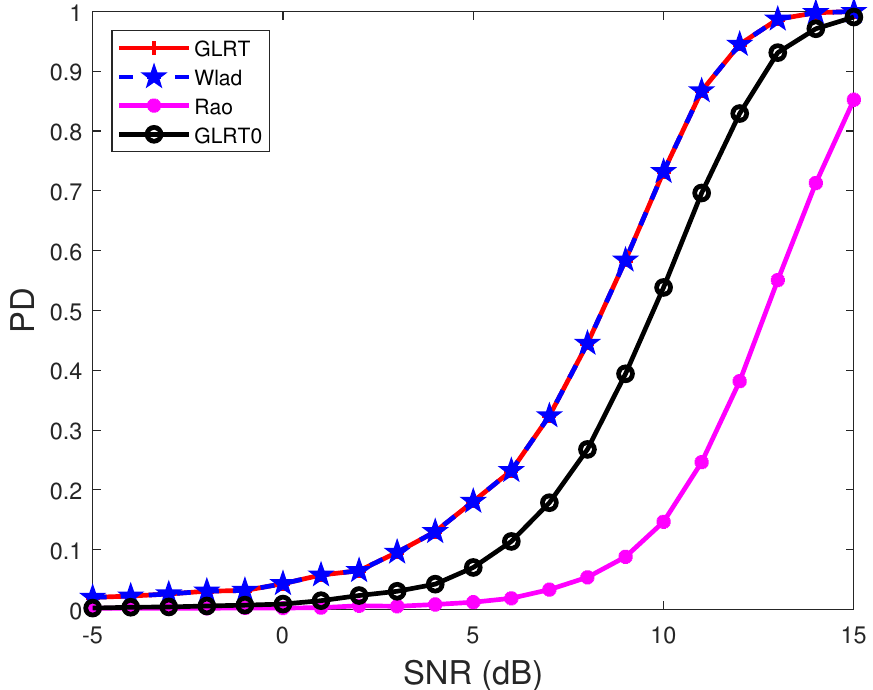
Figure 1. PDs of the detectors under different SNRs. R ( i 1 , i 2 ) = 0.95 | i 1 − i 2 | , N = 8, p = 1, M = 2 N , θ t = 0.2, θ 1 = 0.25, θ 2 = 0.4, and INR = 5